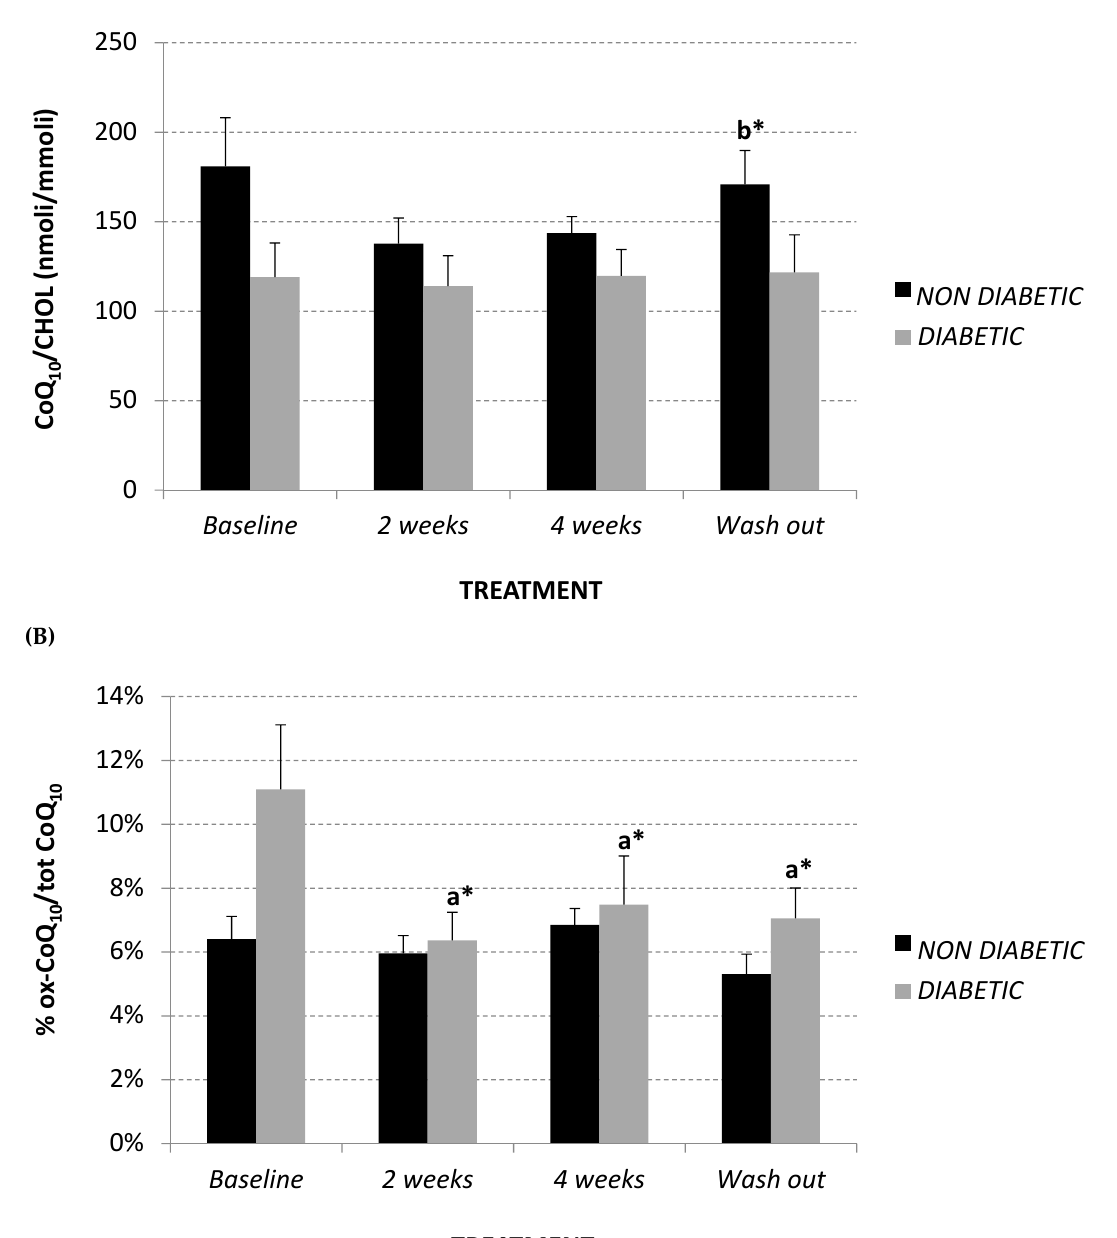
Figure 3. Plasma CoQ 10 / Cholesterol levels (nmol / mmol) ( A ), and % oxidized CoQ 10 / total ( B ) at baseline, after 2 and 4 weeks of Afriplex GRT treatment, and following 4 weeks wash-out in non-diabetic (black) and diabetic (grey) vervet monkeys. * p < 0.05 comparing di ff erent experimental points for each group. a = baseline, b = 2 weeks-treatment.